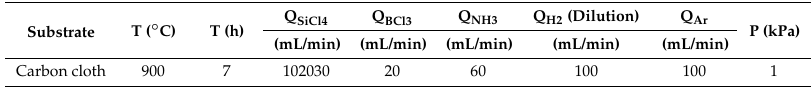
Table 1. Deposition parameters of SiBN coating with SiCl 4 -BCl 3 -NH 3 -H 2 -Ar system via low